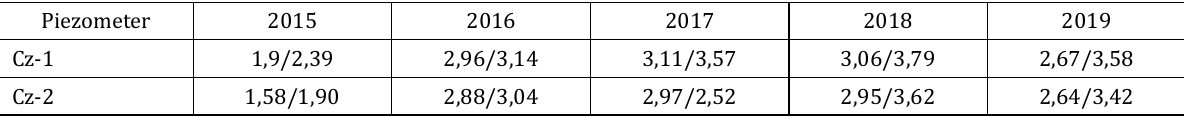
Table 4. LWPI values in piezometers monitoring the Jurassic aquifer in the years 2015-2019